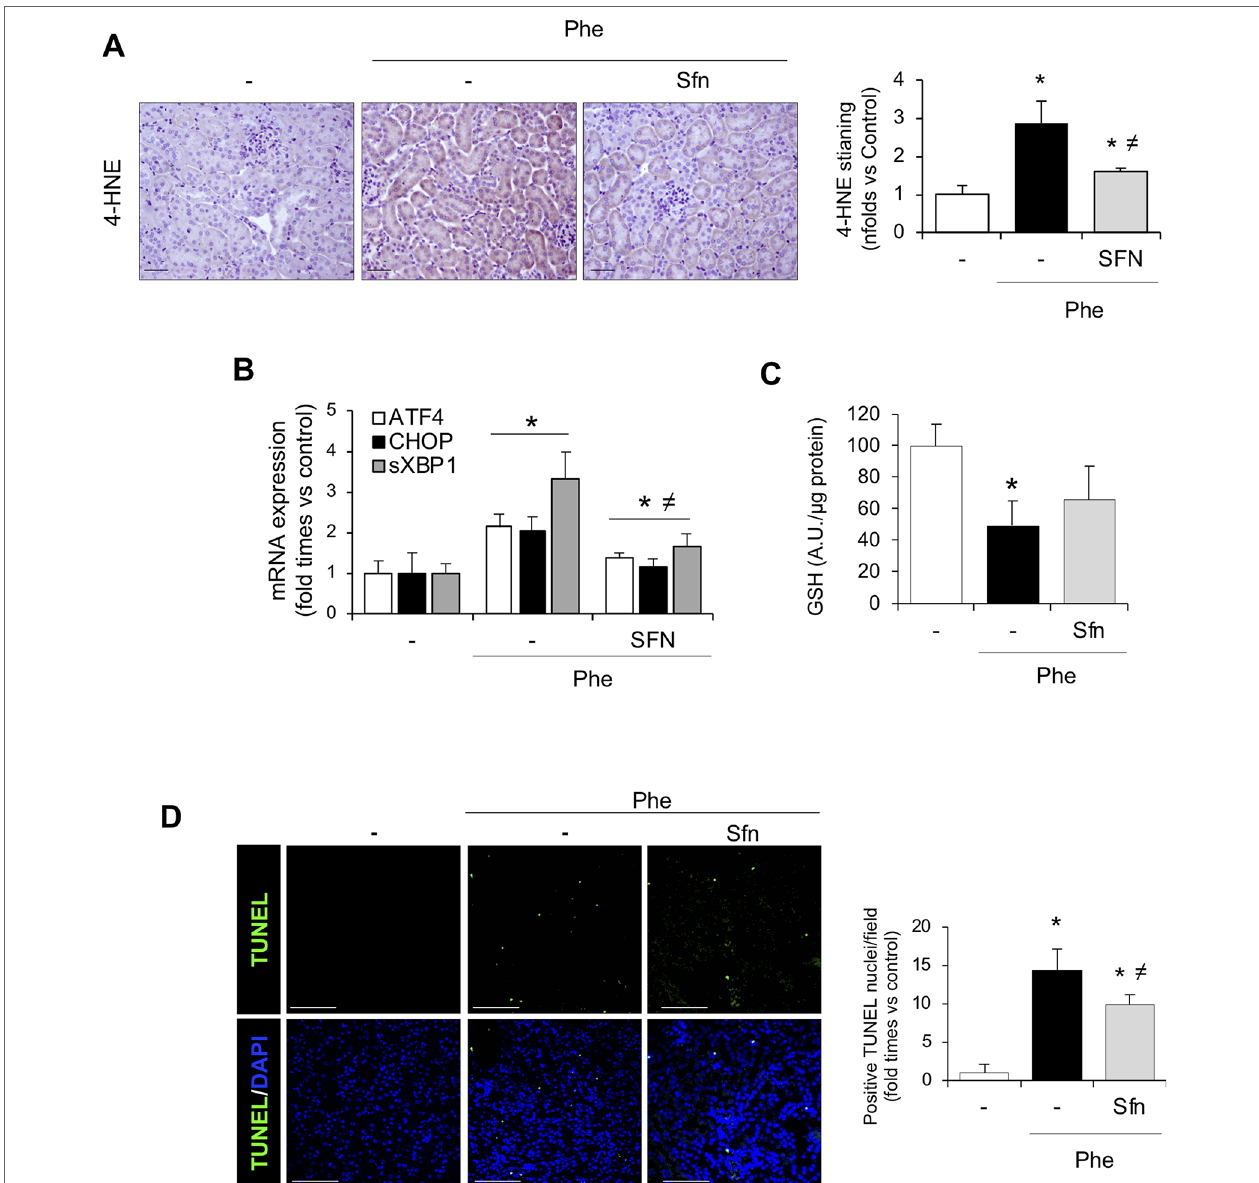
FIGURE 8 | Nrf2 activation pathway in kidney from SFN-treated mice. (A) Representative image of 4-HNE staining in the experimental model (left). Semi-quantification 4-HNE-positive staining per cross section (right). (B) ATF4, CHOP, and sXBP1 mRNA levels determined in kidney by real-time RT-qPCR. (C) GSH content in renal tissue. (D) Representative confocal microscopy images showing nuclear staining of TUNEL (green) (left) and semi-quantitative analysis of TUNEL-positive cells (right). Nuclei were stained with DAPI (blue); scale bar, 100 μm. Results are expressed as mean ± SEM. * p < 0.05 vs control mice, ≠ p < 0.05 vs Phe-injected